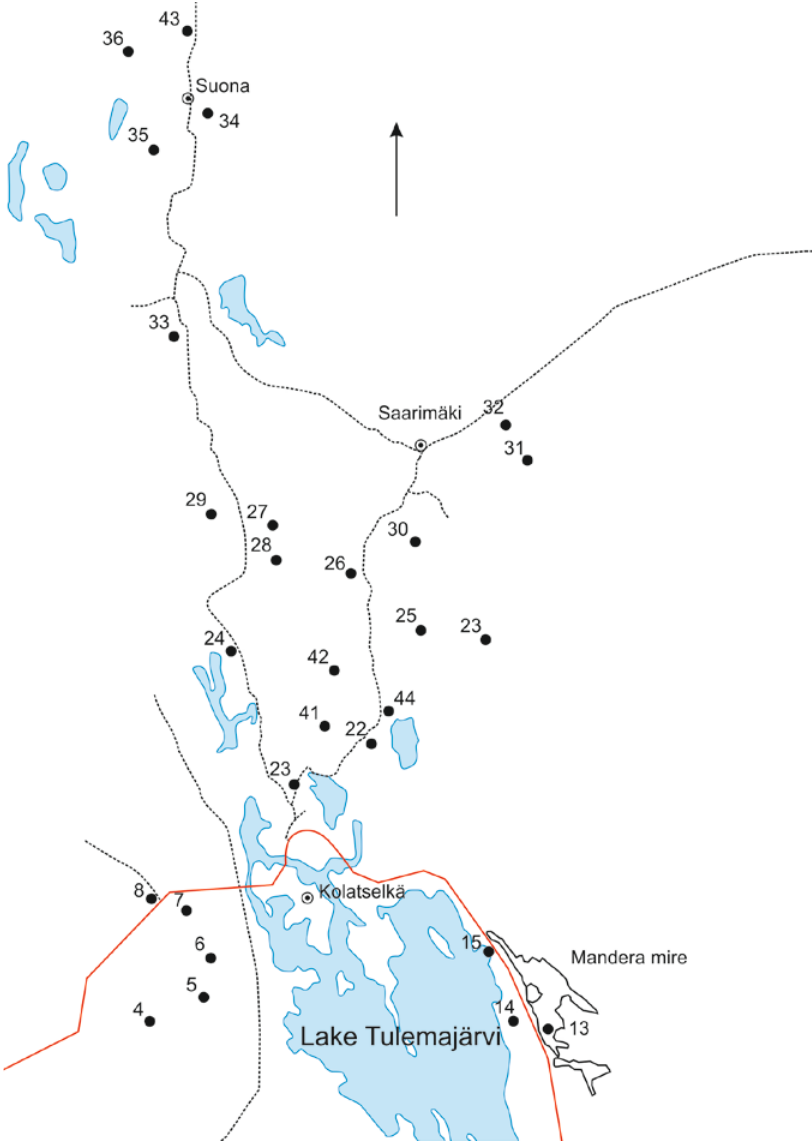
Figure 6. The mires studied by Lounamaa (1961) (numbers 1–36) and additional mires studied in the 2000s (other